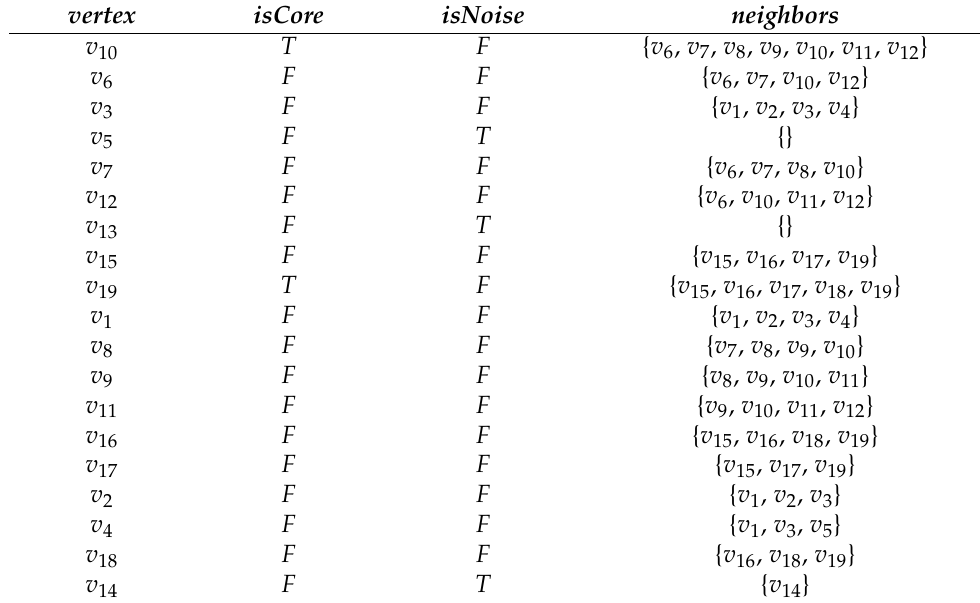
Table 3. NNG after the algorithm ends. vertex isCore